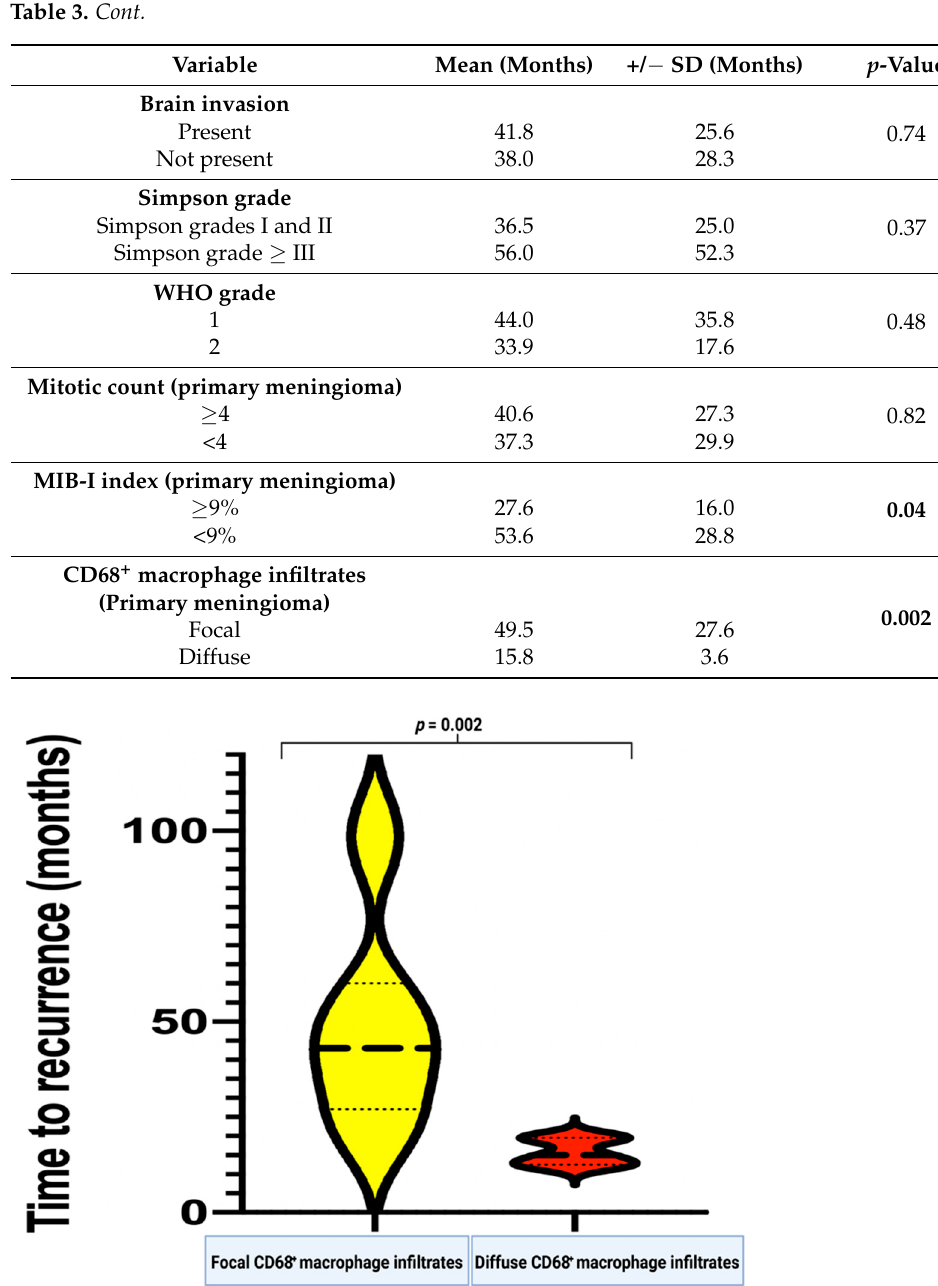
Figure 3. Violin plots showing the time to recurrence (in months) in relation to the extent of CD68 + macrophage infiltrates, which were semi-quantitatively determined (yellow constitutes the focal infiltration and red constitutes the diffuse infiltration).